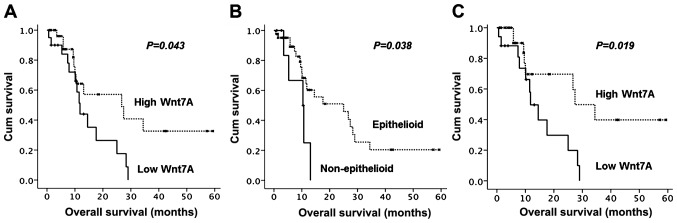
Kaplan-Meier survival curves stratified by Wnt7A expression. (A) Overall survival of all patients according to Wnt7A expression (n=50). (B) Overall survival of all patients according to histological subtype (epithelioid vs. non-epithelioid). (C) Overall survival of patients with epithelioid tumors according to Wnt7A expression.